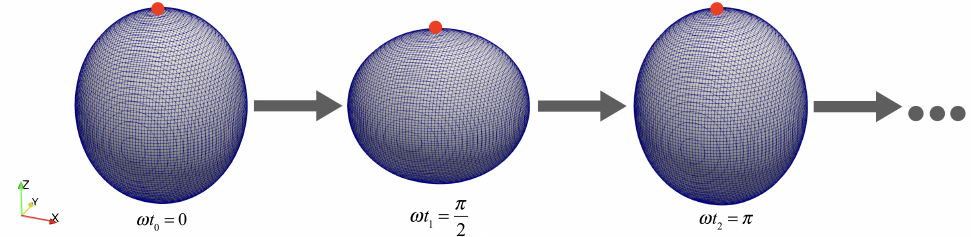
Figure 4. Illustration of the droplet oscillation